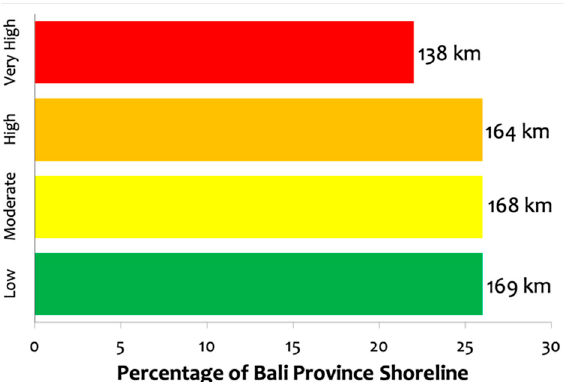
Figure 6. The shoreline length of vulnerability categories as determined by CVI.